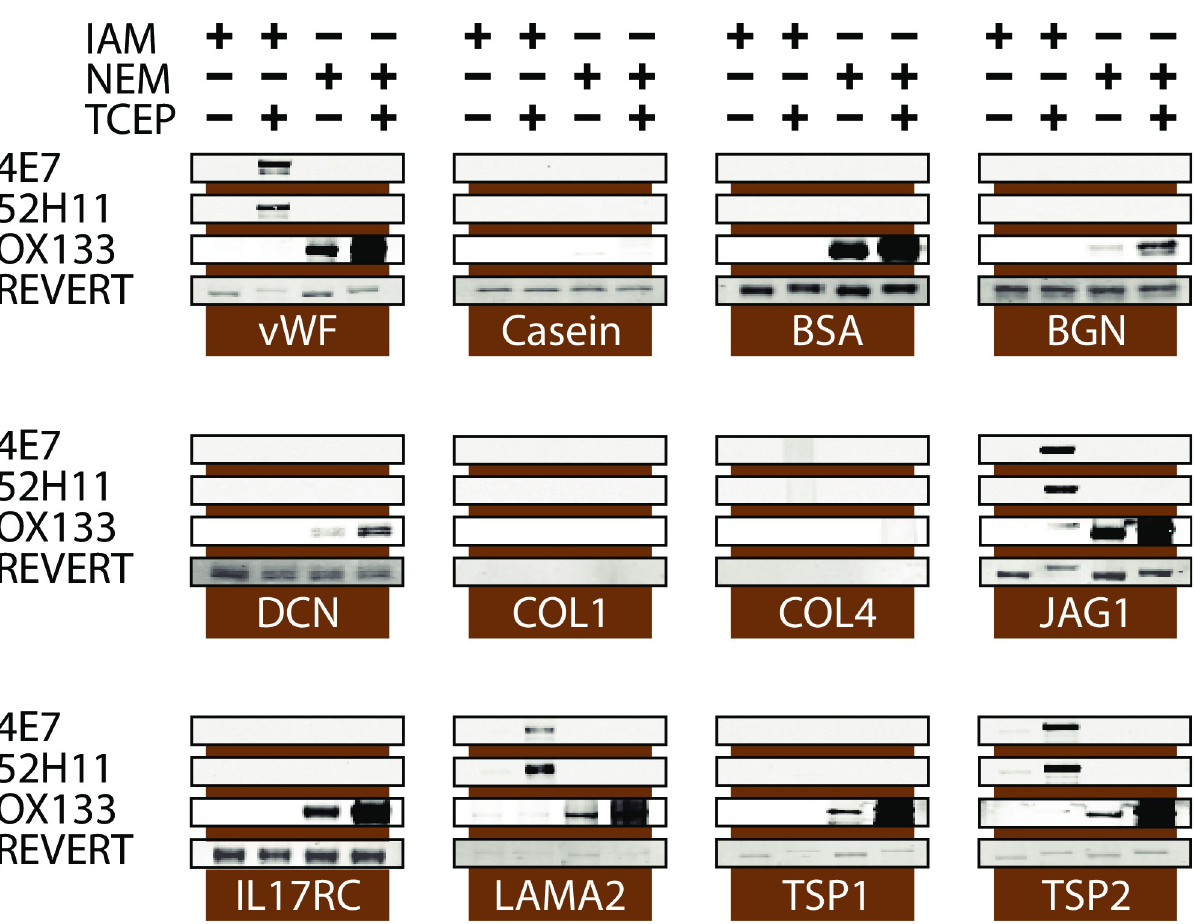
Fig 6. Antibodies to CAM-cys selectively target purified proteins. A series of purified proteins were treated in the presence or absence of the non- thiol reductant TCEP (2.5mM) with IAM or NEM (5mM). Proteins were then analyzed by Western blotting with 4E7, 52H11, or OX133. Selected CAM-cys labeled proteins reacted with 4E7 and 52H11. Equal loading of proteins was demonstrated by staining membranes with a non-selective protein stain (Revert, LI-COR). Proteins migrated at the expected molecular masses as follows (approximations): beta casein (27 kDa), BSA (65 kDa), BGN (40 kDa), DCN (38 kDa), COL1 ( > 250 kDa), COL4 ( > 250 kDa), JAG1 (170 kDa), IL17RC (75 kDa), LAMA2 ( > 180 kDa), vWF (260 kDa), TSP1 (150 kDa), TSP2 (155 kDa).